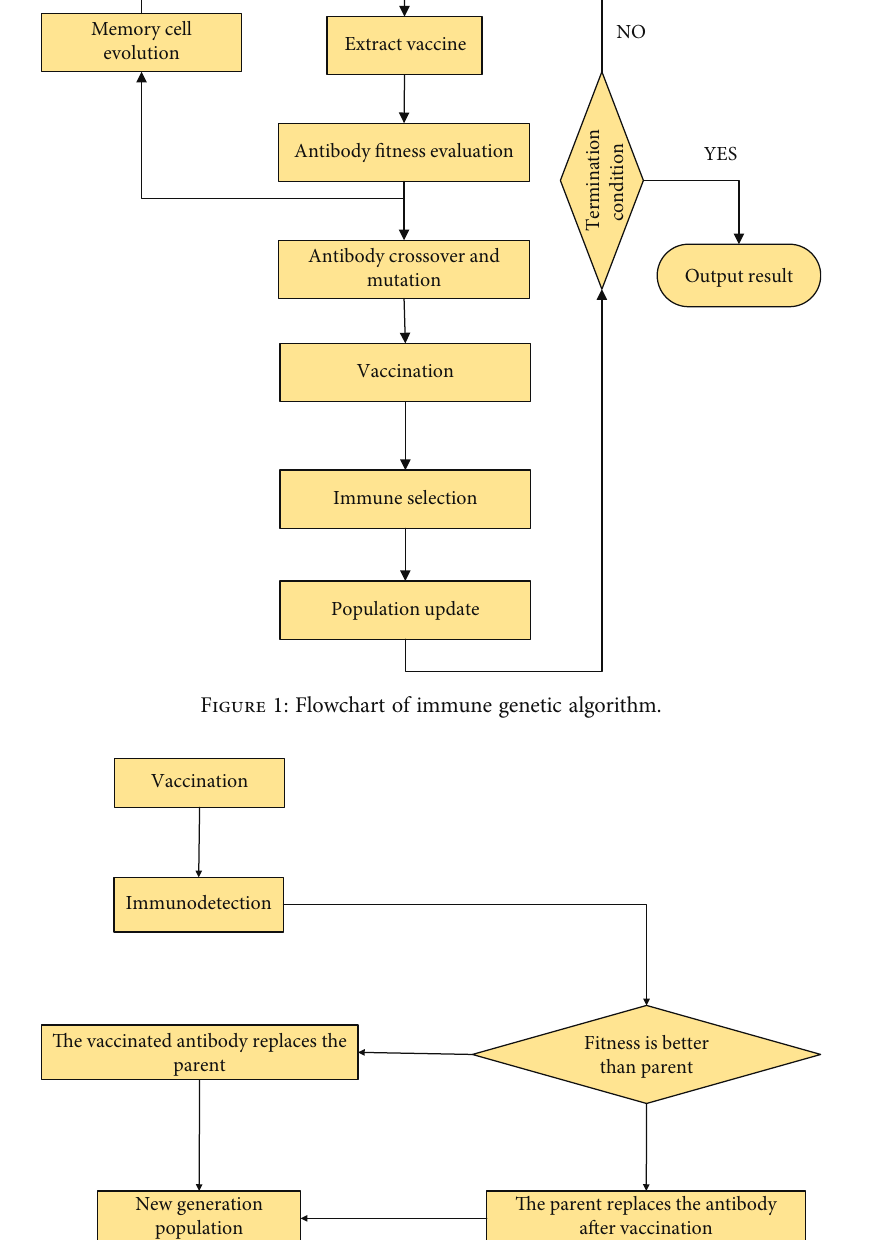
Figure 2: Immunoselection